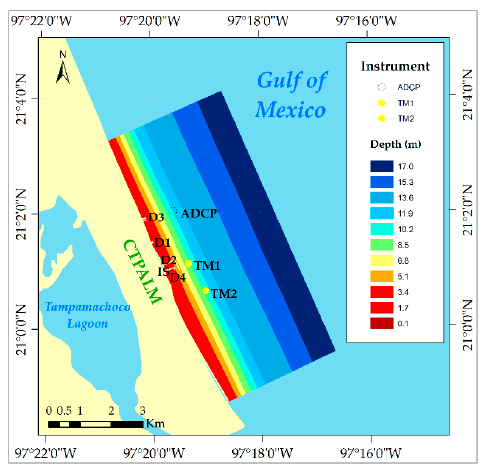
Figure 3. Bathymetry of the study zone.